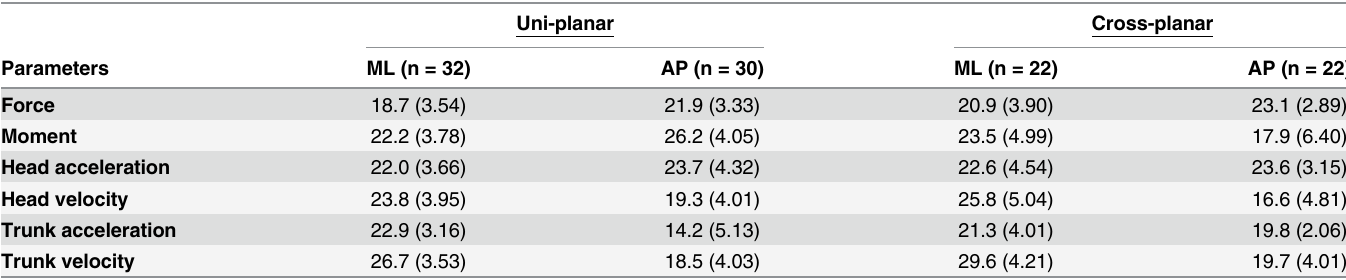
Table 2. Mean (SEM) percentage improvement across all subjects responsive to SVS for different measures in the optimal stimulus trials during stimulus period normalized to baseline period value with respect to that for the control trial for uni-planar (ML or AP separately), and cross-planar (both ML and AP combined)